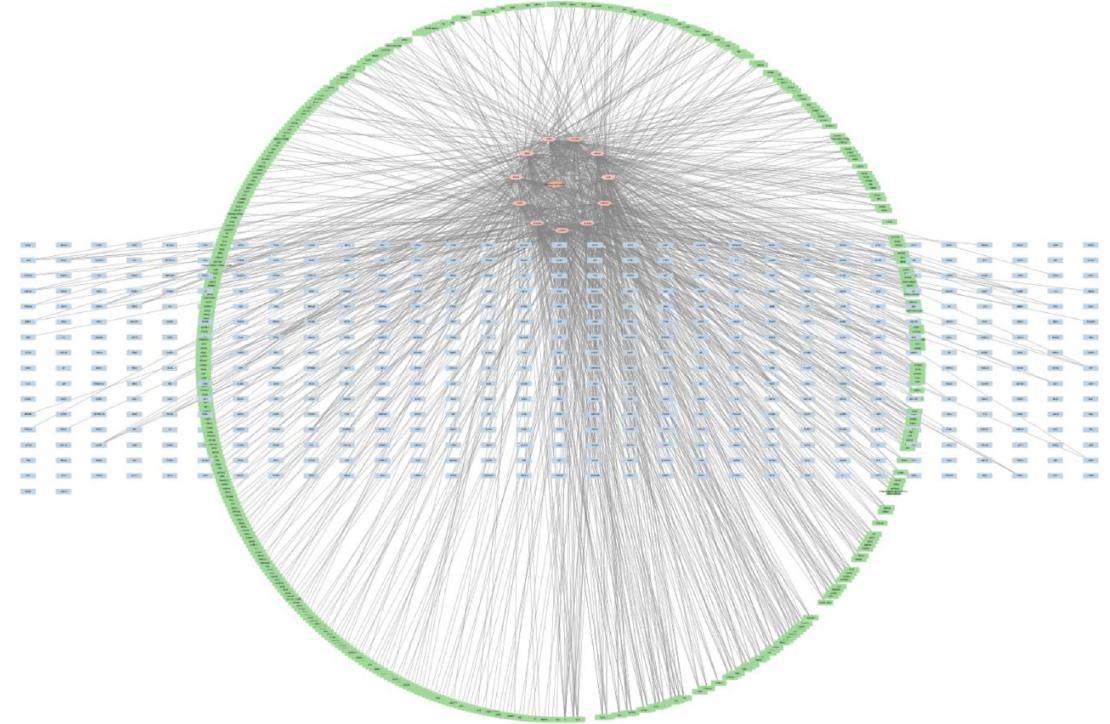
Fig 2. Construction C-T-D network. The pink colour represents compounds. The green colour represents targets related to the compounds and blue represents disease-related genes.